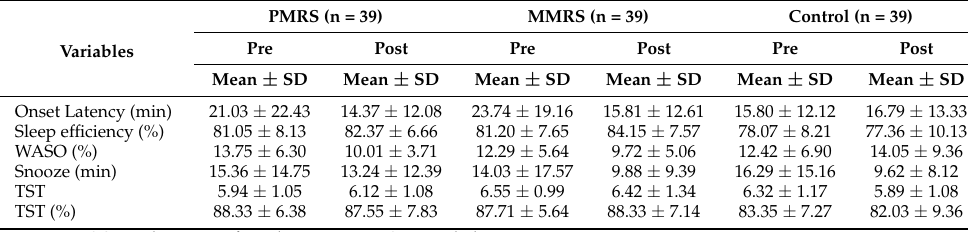
Table 4. Distribution of objective sleep parameters scores between pre- and post-intervention.